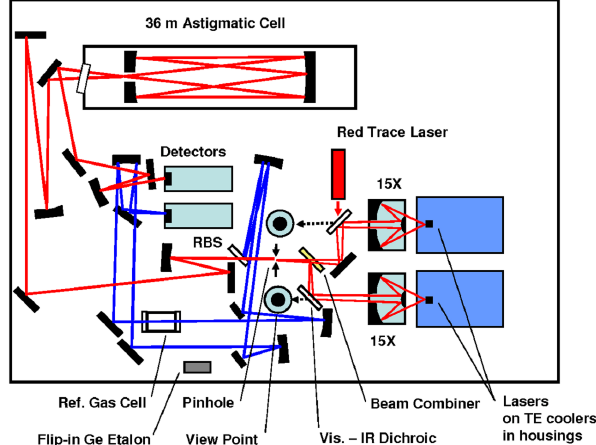
Figure 1. Scheme of the optical board of the SICAS (figure adapted from McManus et al., 2015). Two pathways are shown, both con- sisting of signals from both lasers: the sample measurement beam in red and the reference beam in blue. The reference pathway is in our case only used for fitting purposes. RBS stands for reference beam splitter. One of the detectors is used to read the signal of the sample beam, the other for the reference beam. The red trace laser is co-aligned with the sample path to visualize the sample pathway to ease